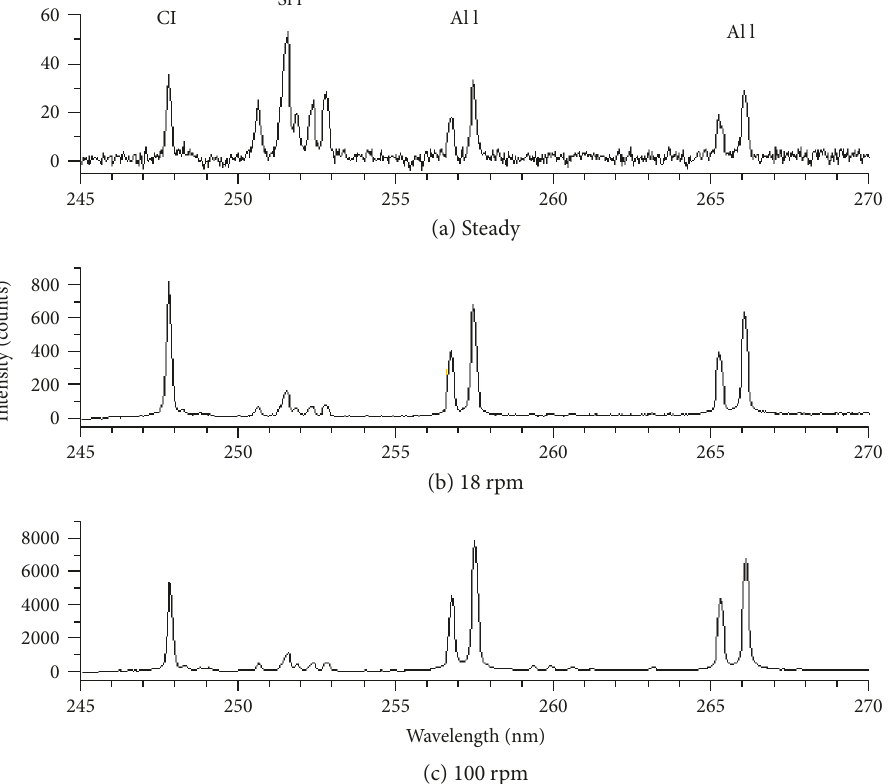
Figure 2: LIBS spectra from diesel, averaged over 10 laser pulses with energy of 23mJ. Steady droplet (a) and support rotated at 18 rpm (b) and 100 rpm (c).